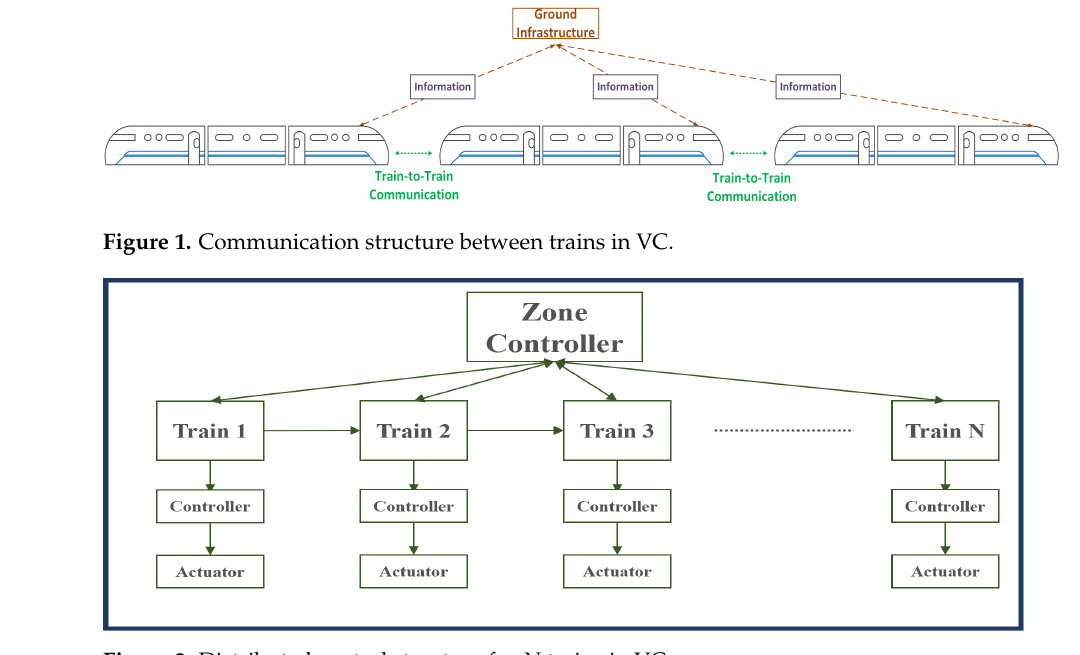
Figure 2. Distributed control structure for N trains in